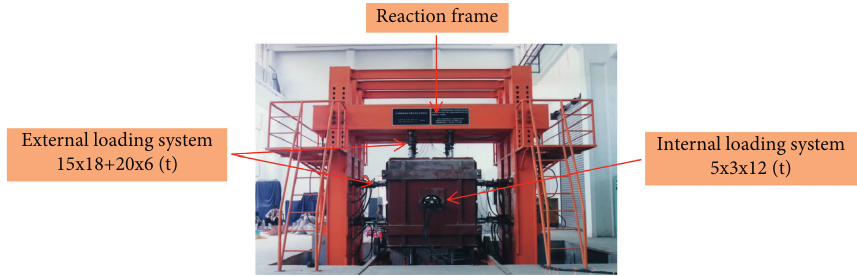
Figure 1: Comprehensive experimental system of highway tunnel and surrounding